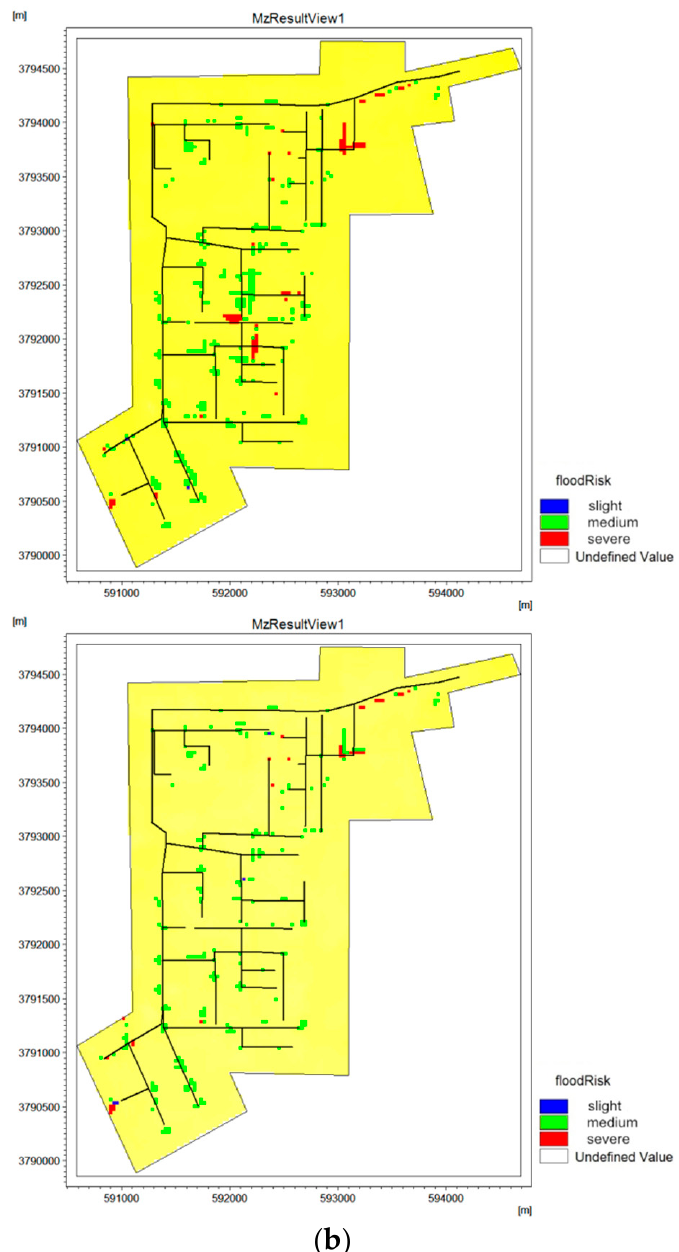
Figure 7. Distribution of the waterlogging risk. ( a ) Distribution of the waterlogging risk during the 5-year recurrence interval with no rain garden and rain garden regulation; ( b ) Distribution of the waterlogging risk during the 20-year recurrence interval with no rain garden and rain garden regulation.